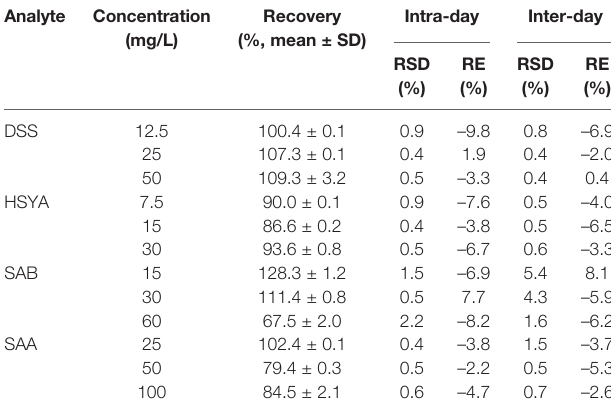
TABLE 2 | Precisions and recoveries of each reference substance ( n = 5). Analyte Concentration (mg/L)